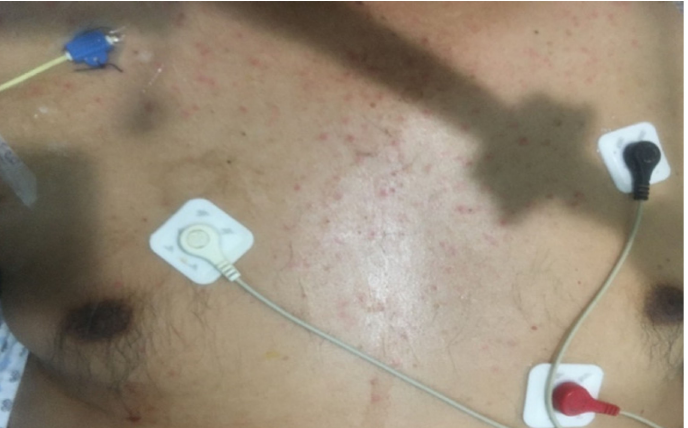
Figure 2. Erythematous, confluent, and predominantly perifollicular maculopapular rash in a patient diagnosed with COVID-19 and admitted to critical